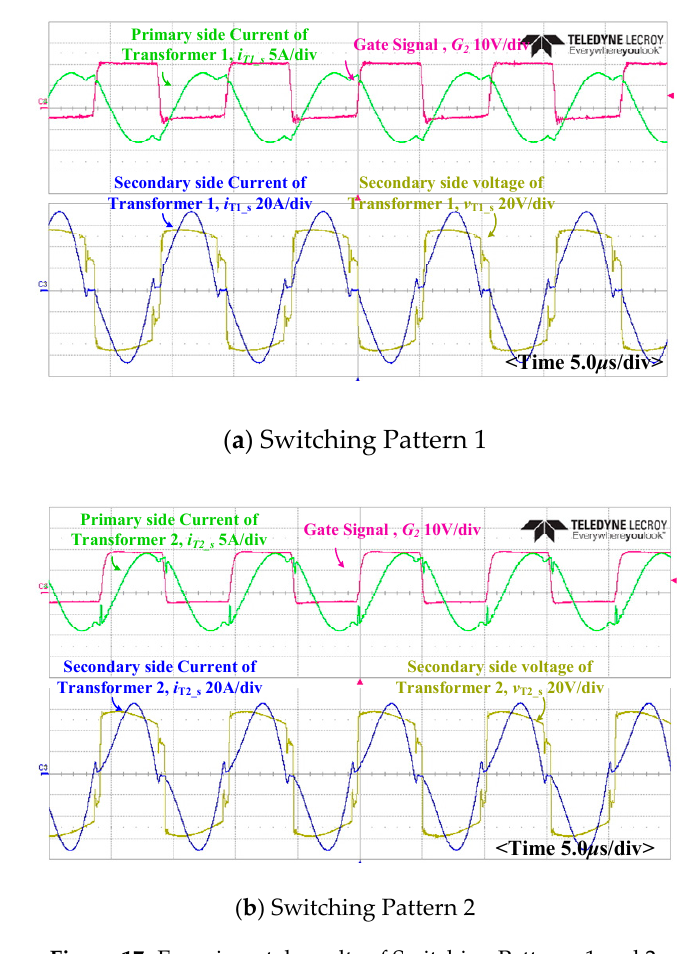
Figure 17. Experimental results of Switching Patterns 1 and 2.